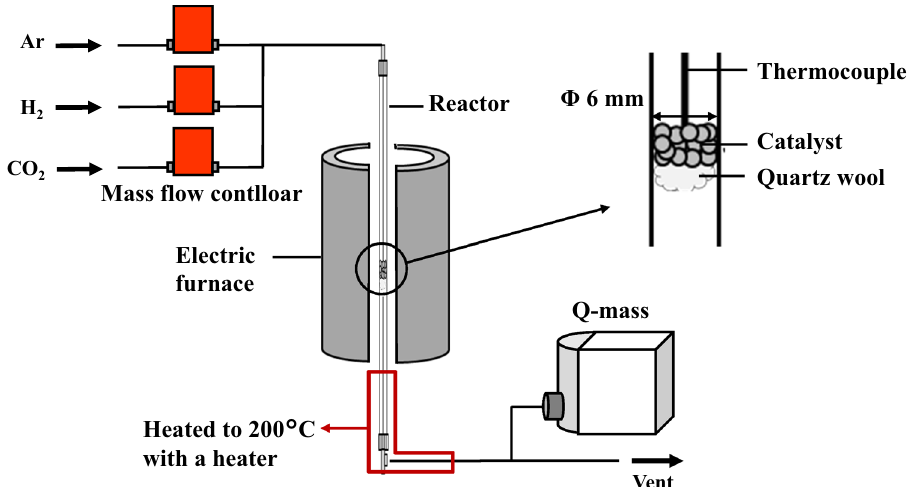
Figure 2. Schematic diagram of the vertical fixed bed tubular